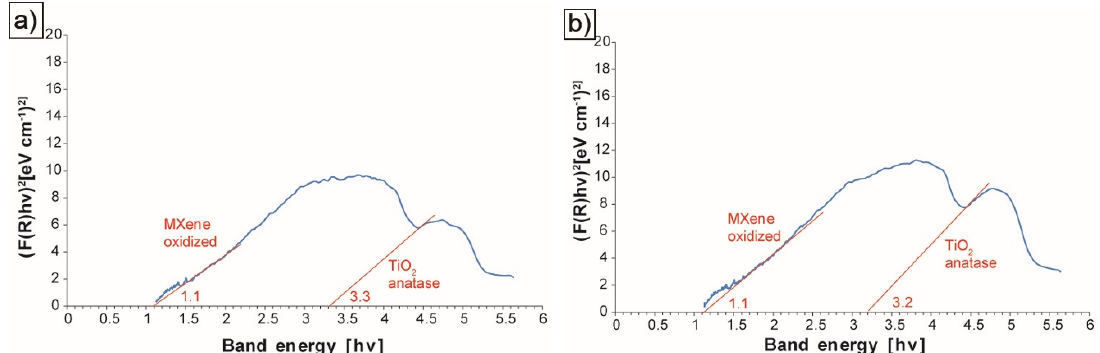
Figure 4. The plot of the Kubelka-Munk function in a function of band energy for ( a ) Ti 3 C 2 MXene annealed at 1600 °C in argon, ( b ) Ti 3 C 2 MXene annealed at 1600 °C in vacuum .